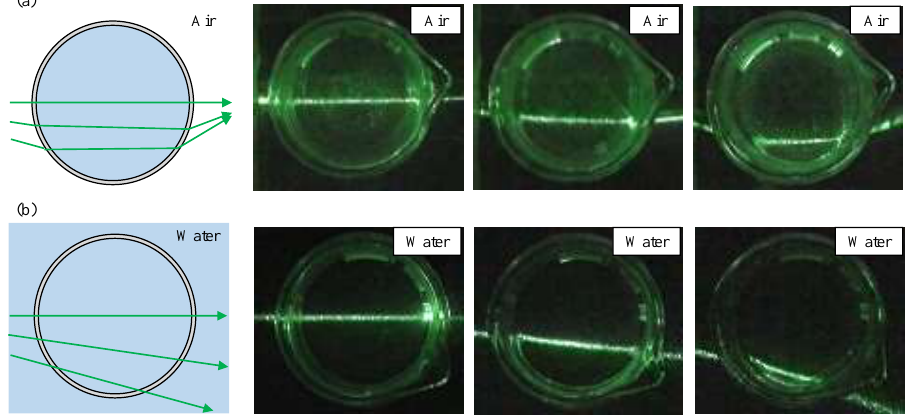
Figure A2. The path ways of non-parallel laser beams pass through a glass bottle. ( a ) The refraction of light without a water bath and ( b ) the refraction of light with a water bath.